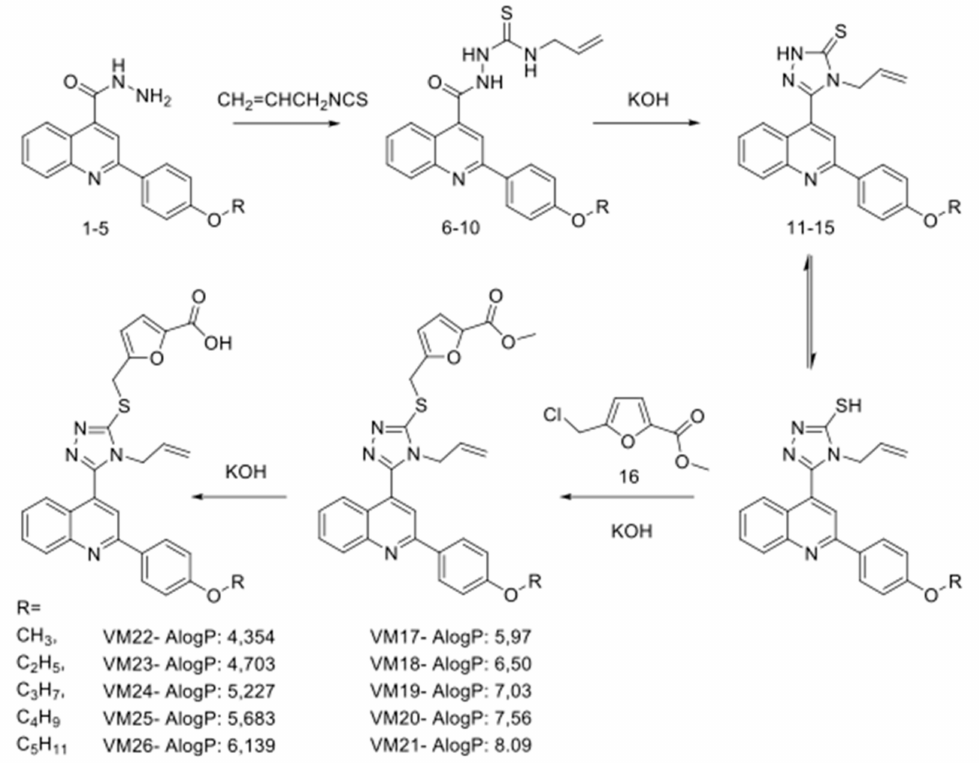
Figure 1. Synthetic route and structures of furfuryl derivatives of